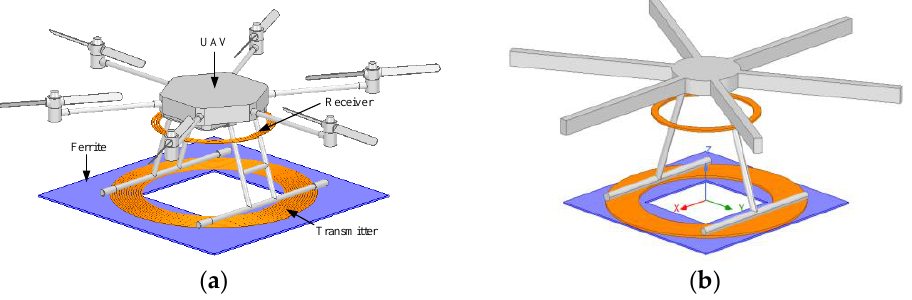
Figure 1. General overview of the proposed magnetic coupler. ( a ) Original 3D model; ( b ) simplified 3D model.